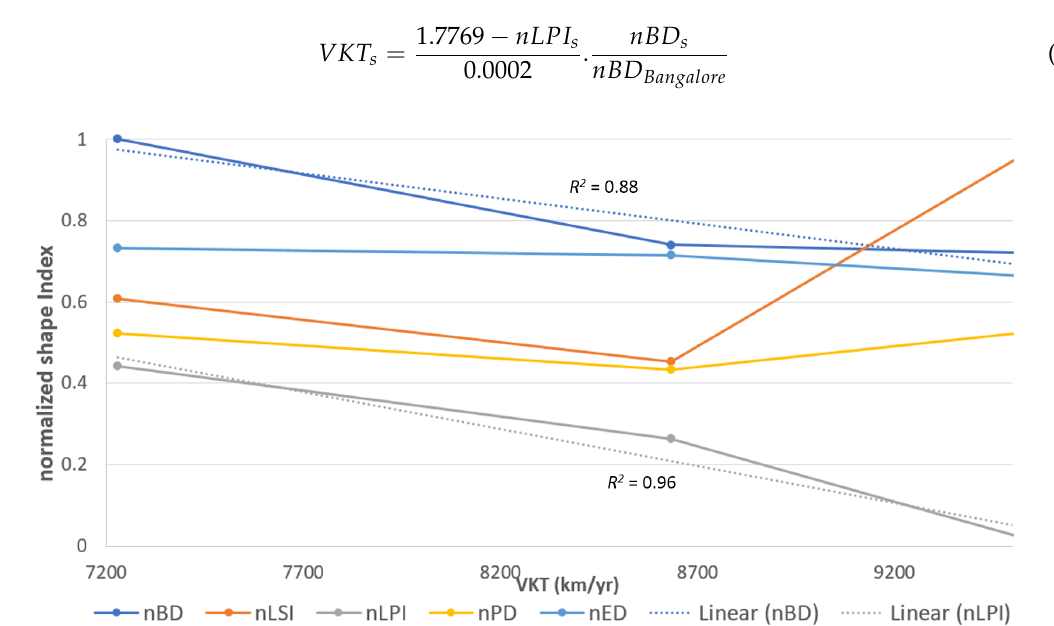
Figure 5. Correlation of vehicle kilometers traveled (VKT) of Bangalore (8634 km), Delhi (9594 km) and Kolkata (7230 km) with built-up density (nBD): 0.88, landscape shape index (nLSI): 0.37, largest patch index (nLPI): 0.96, patch density (nPD): 0.0002 and edge density (nED): 0.84.